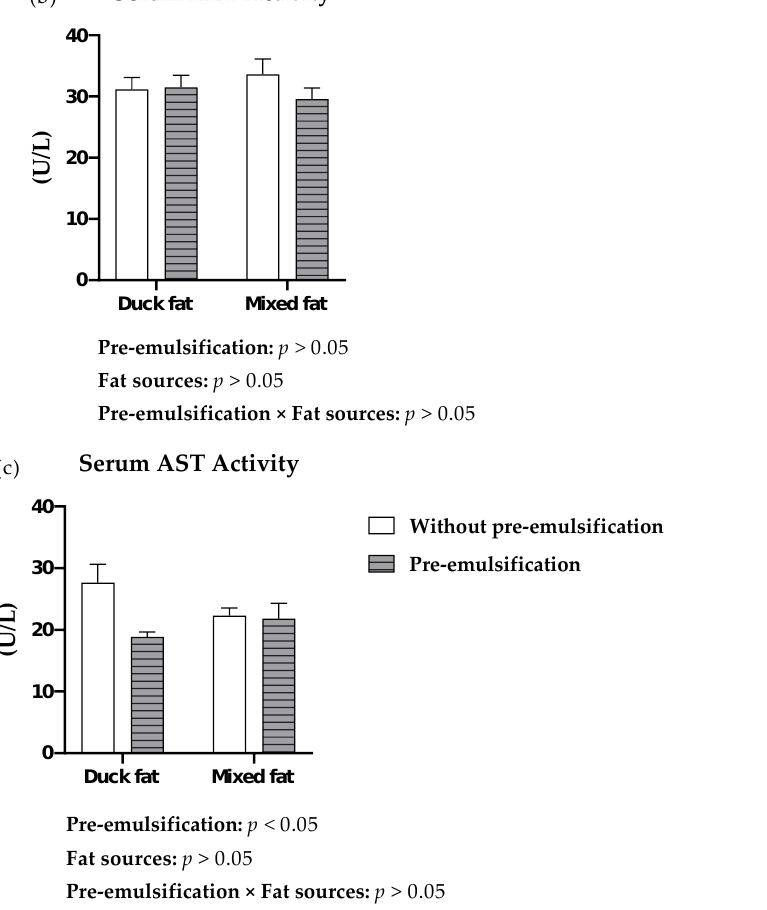
Figure 1. Effects of fat sources and fat pre-emulsification on the liver index ( a ), and the activity of ALT ( b ) as well as AST ( c ) in serum of 34-day-old meat ducks. Table 4. Effects of fat sources and pre-emulsification on serum biochemical index of ducks at 34 days of age 1,2 .